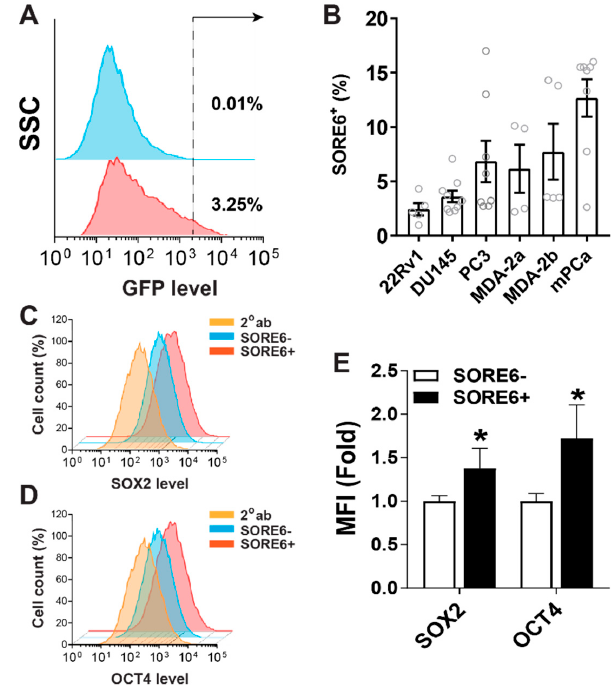
Figure 1. The SORE6 reporter identifies a subpopulation of PCa cells expressing high levels of SOX2 and OCT4. ( A ) A representative flow cytometry analysis of 22Rv1 cells expressing mCMV-GFP (top panel) or SORE6-GFP (bottom panel). ( B ) Percentage of SORE6 + cells in a panel of PCa cells identified by flow cytometry. ( C – E ) Flow cytometry analysis of SOX2 and OCT4 expression in SORE6 + and SORE6 − PC3 cells. The representative flow cytometry plots are shown in ( C ) (SOX2) and ( D ) (OCT4). The cells were stained with anti-SOX2 or OCT4 antibody followed by Alexa568-conjugated secondary antibody or secondary antibody alone (2°ab). The mean fluorescence intensity (MFI) from 3 to 4 independent experiments expressed as fold changes of MFI in SORE6 + cells over SORE6 − cells is shown in ( E ). * p < 0.05 versus SORE6 −